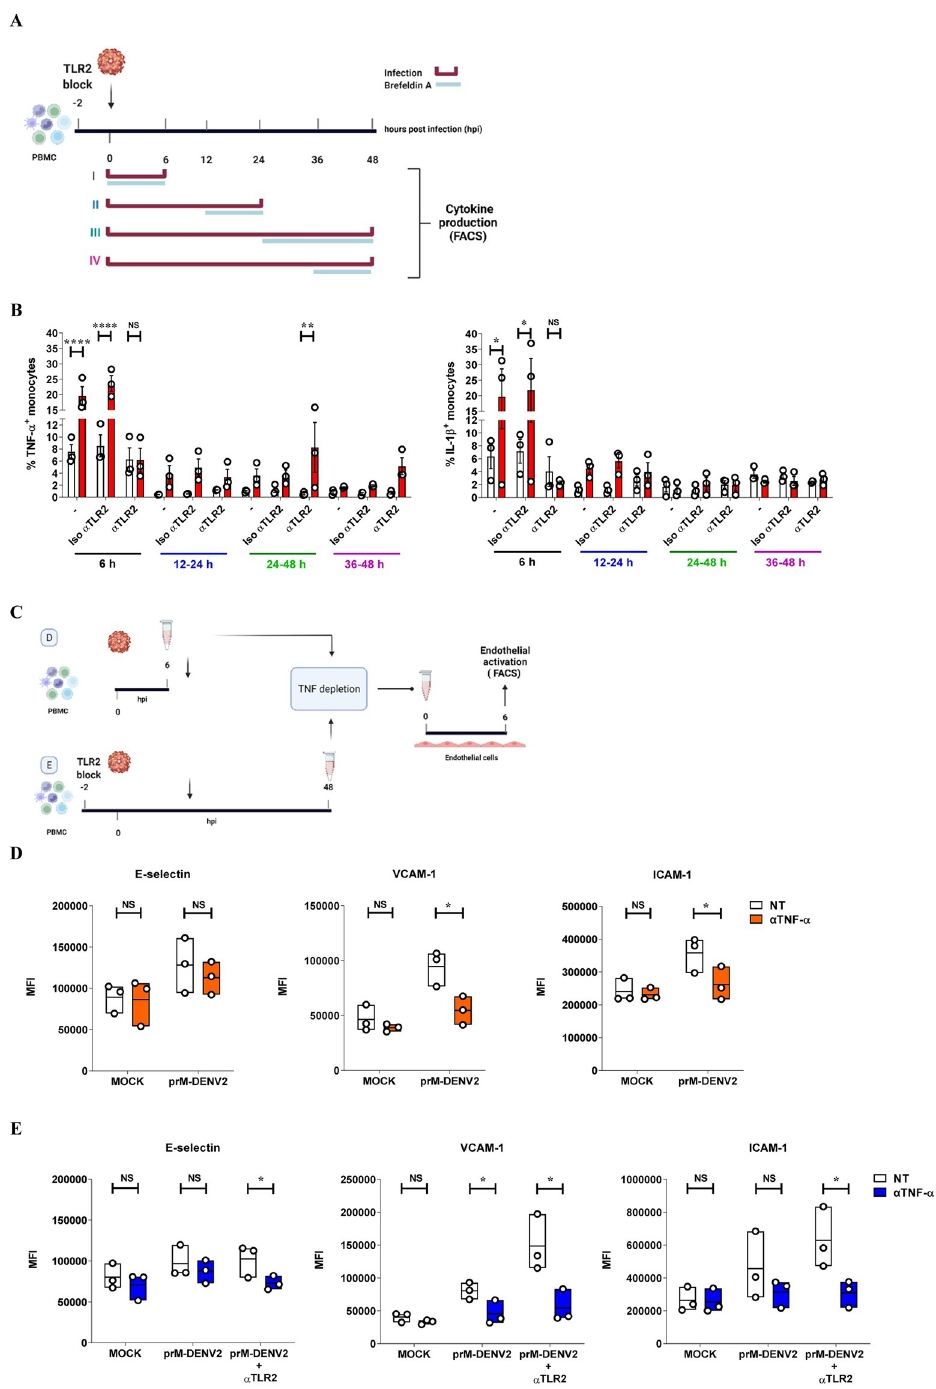
Fig 7. Prolonged TLR2 block induces the release of TNF- α by monocytes exposed to prM-DENV2 and drives EC activation. ( A ) Experimental scheme: hPBMCs (n = 3, three different donors) were treated with anti-TLR2 or TLR2 isotype control antibody (5 μ g/mL) for 2 h prior exposure to prM-DENV2 (MOG 300) for 6h, 24h, and 48hpi in the presence of Brefeldin-A as indicated in the scheme. ( B ) Percentage of monocytes (in PBMCs) with intracellular expression of TNF- α and IL-1 β was measured by flow cytometry. ( C ) Experimental scheme: supernatants from PBMCs (n = 3, three different donors) exposed to prM-DENV2 for 6h and 48 hpi, were incubated for 1h in the presence or absence of anti-TNF- α antibody (4 μ g/ml). PBMCs exposed to prM-DENV2 for 48h were treated with anti-TLR2 2h prior prM-DENV2 stimulation. TNF- α -depleted PBMCs supernatants were used to stimulate HUVEC